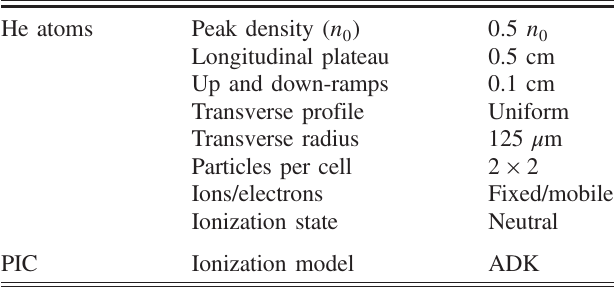
TABLE VI. Control simulations scan He impurity parameters for the configuration with short, narrow drivers (FACET-II).